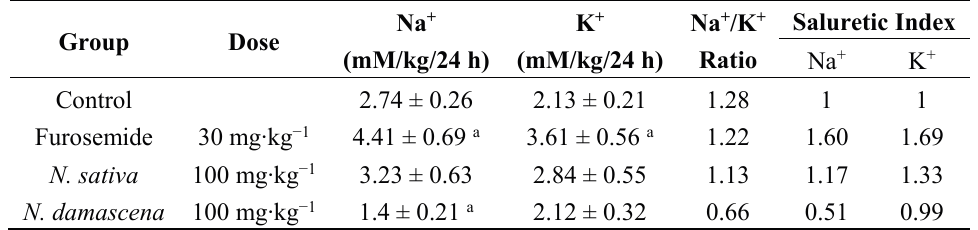
Table 5. Effect of Nigella ethanolic extracts and furosemide on the concentrations of urinary electrolytes in 24 h of urine collection. Drugs were given orally ( n = 6). Group Dose (mM/kg/24